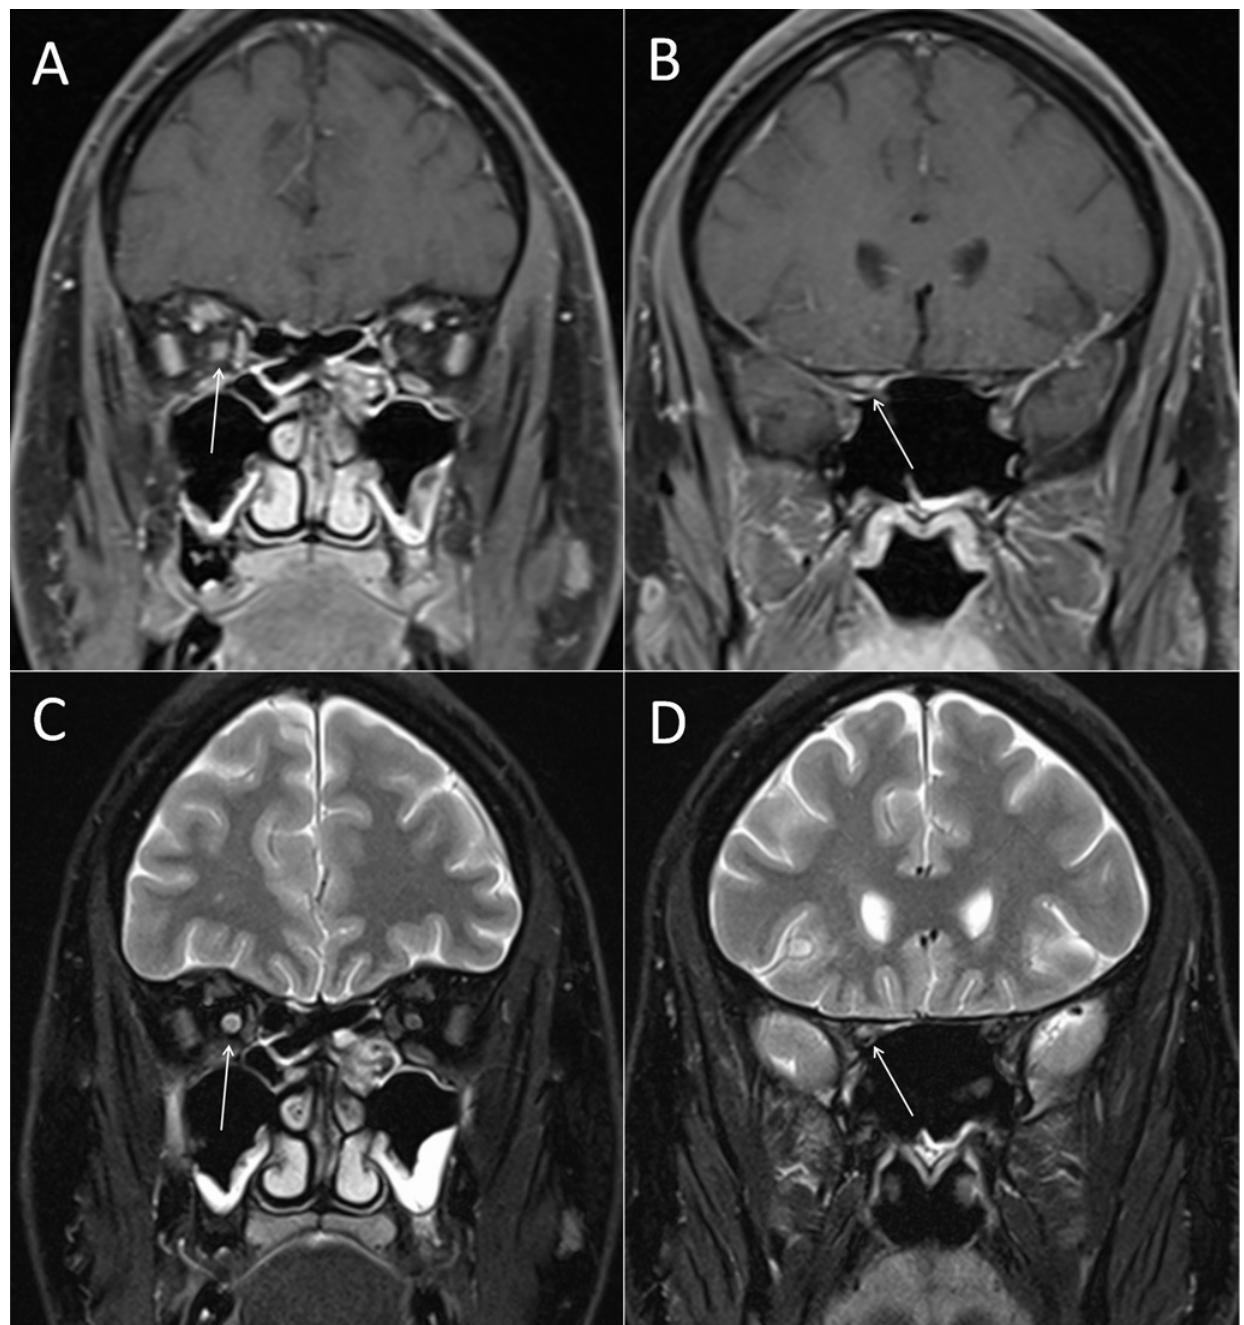
Figure 1. Gd enhancement and T2 lesion of the right optic nerve. Optic nerve MR imaging of a representative patient with ON. (A) Coronar fat-saturated T1-weighted MRI sequences of the intraorbital and (B) canalicular part of the optic nerve after application of 0.1mmol/kg gadolinium. The arrows highlight the Gd enhanced right optic nerve. (C) Signalalteration of the intraorbital and (D) canalicular part of the optic nerve in coronar fat-saturated T2 turbo spin-echo MRI sequences. The arrows highlight the hypertense T2 lesion of the right optic nerve.